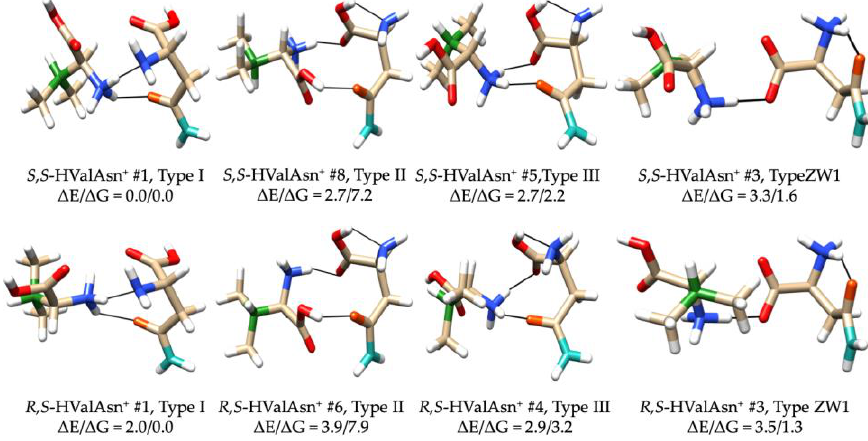
Figure 4. Type I, II, III, and ZW binding topologies of S , S -HValAsn + and R , S -HvalAsn + . The geometries shown are the most stable isomer in each type. The monomer subunit on the left is S - or R -Val, while the one on the right is S -Asn. The relative ZPE corrected electronic energy (ΔE) and Gibbs free energy (ΔG) at room temperature in kJ mol -1 at the B3LYP-D3BJ/def2-TZVP level of theory are included. The ranking #1, #2, etc., is based on ΔG and is done for the homo- and heterochiral HvalAsn + , separately. The ΔE and ΔG values between the most stable isomers of S,S - and R,S -HvalAsn + are 1.7 and 0.7 kJ mol -1 , respectively, with S,S -HvalAsn + Type I #1 being the most stable one.